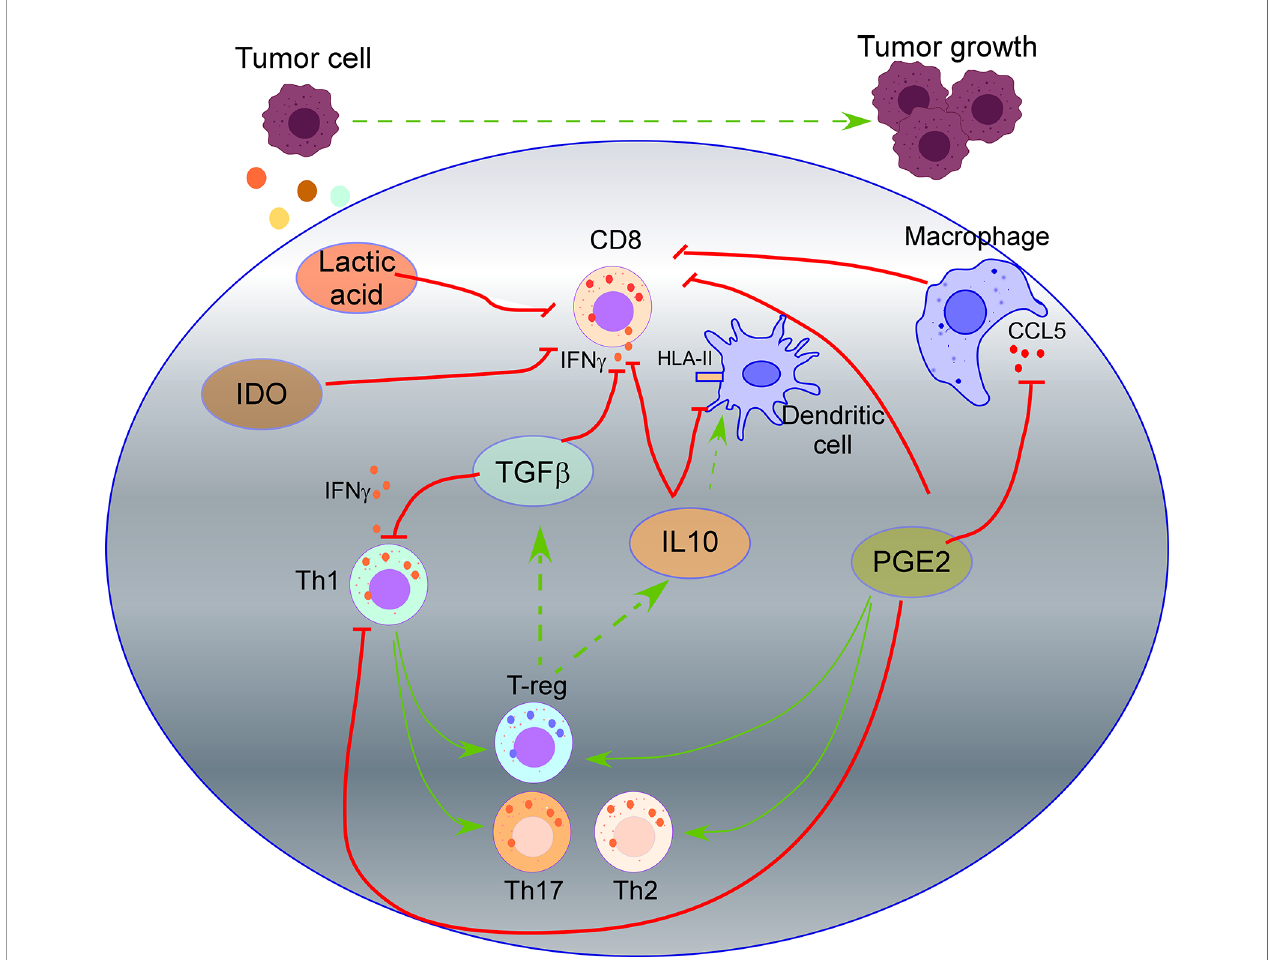
FIGURE 1 | Impact of tumor secretome in T cell activity. TGF- b secreted by tumor cells suppresses IFN- g production by Th1 and effector CD8 T cells, inducing the differentiation of CD4 T cells to regulatory (T-reg) cells and Th17 cells. T-reg cells also release TFG- b and IL10 that will suppress the activation of CD8 T cells. IL10 secreted by tumor cells down-regulates HLA-II on dendritic cells, inhibiting antigen presentation. Prostaglandin 2 (PGE2) secreted by tumor cells suppresses the functions of CD8 T cells and Th1 cells, and promotes Th2, Th17, and T-reg cell response. PGE2 reduces CCL5 production by macrophages, which is required for T cell proliferation. Secretion of Indoleamine 2,3 dioxygenase (IDO) by tumor cells produces metabolites that inhibit T cell activity. Lactic acid produced by tumor cells suppresses nutrient uptake by CD8 T